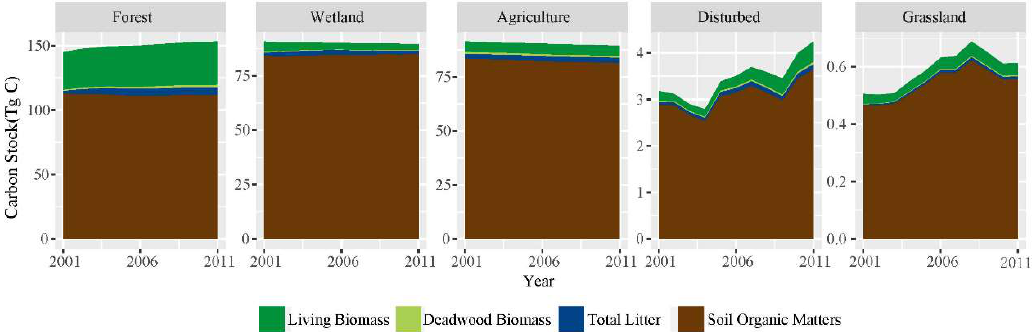
Figure 4. Carbon storage overtime organized by LULC class.